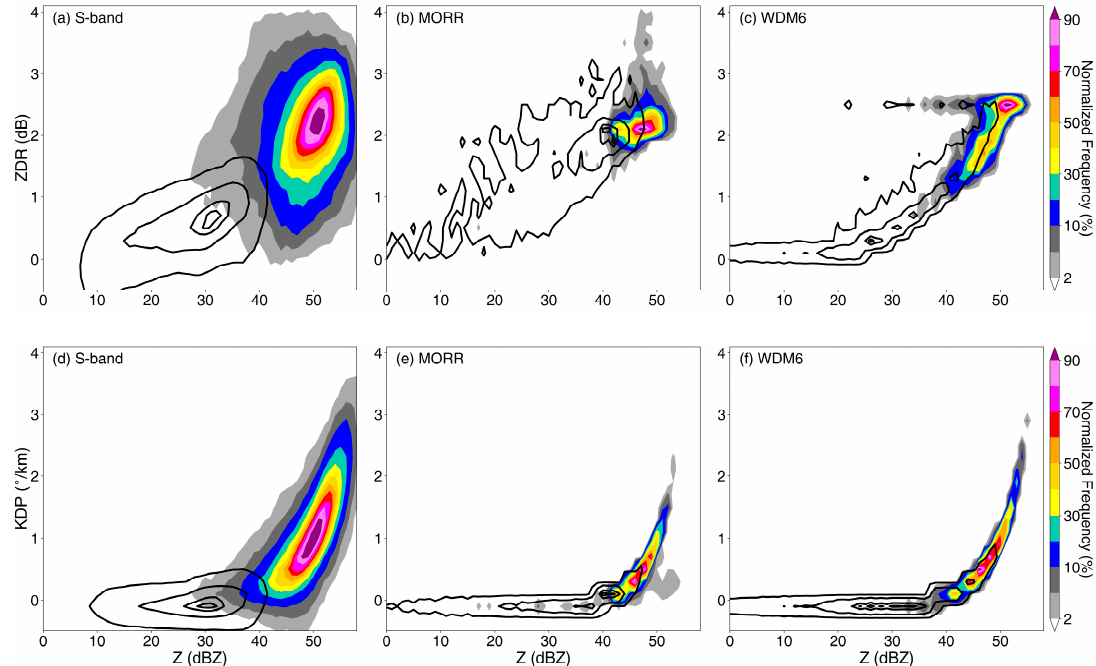
Figure 8. Joint radar reflectivity–differential reflectivity ( Z - Z DR ; top) and reflectivity– specific differential phase ( Z - K DP ; bottom) frequency distributions, normalized by maximum frequency, for 1200–1500 UTC (percent, color shadings from 2% to 100% for the convective region; black contours at 5, 30, 70, and 90% for the stratiform region). ( a , d ) The S-POL radar observations (below 3 km elevation) and POLARRIS-f simulations converted from the WRF output using the ( b , e ) MORR and ( c , f ) WDM6 microphysics schemes. The statistics from the simulations were limited to below approximately 2.75 km. Z was binned from 0 to 60 dBZ every 1 dBZ and both Z DR and K DP were binned from − 0.5 to 4.5 dB (or °/km) every 0.05 dB (or °/km).